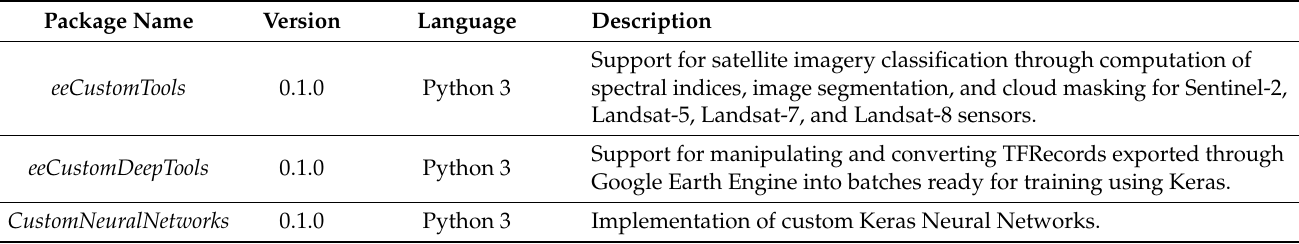
Table 1. Details of the custom packages introduced in the